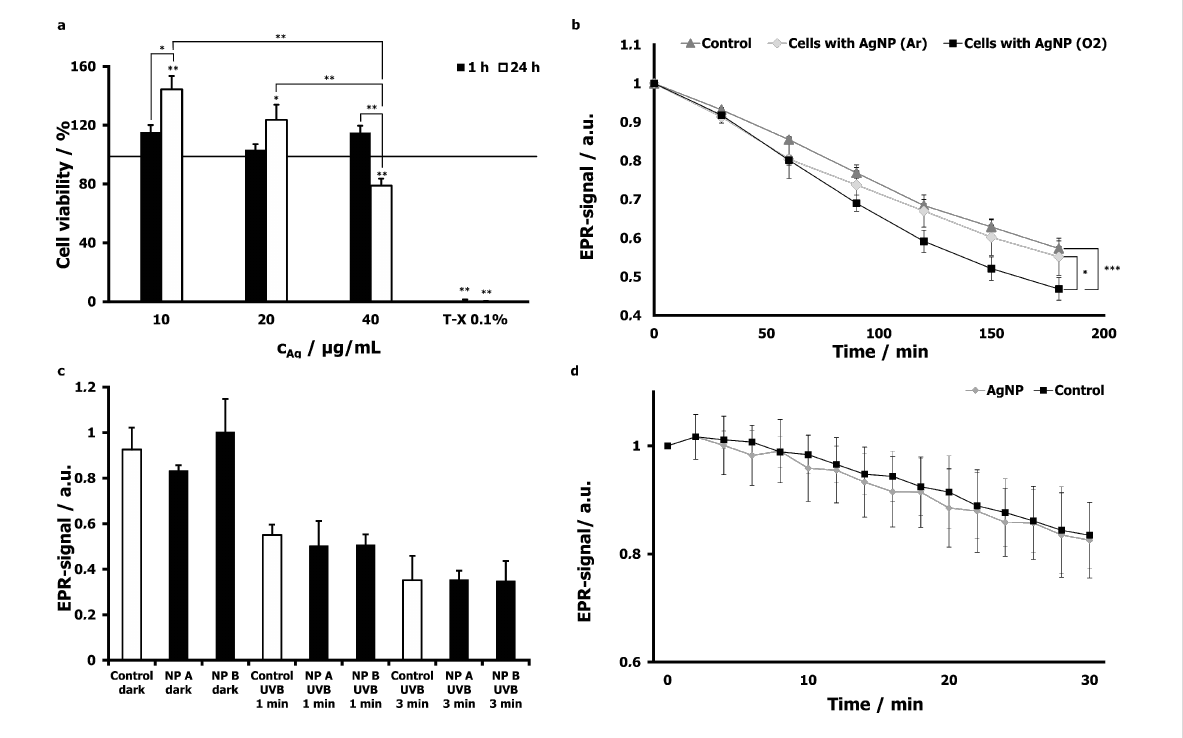
Figure 4: Biological responses of skin tissue and skin cells to particle exposure. The viability of HaCaT cells after 1 h and 24 h incubation with AgNP at different concentrations was assessed by using the XTT assay (a). HaCaT cells were incubated with 30 µg/mL of AgNP produced and stored under ambient air conditions or in argon atmosphere, respectively, and investigated by means of EPR spectroscopy. The used spin marker TEMPO (5 µM) becomes EPR-invisible when reacting with ROS (b). In order to analyze ROS production in whole skin, the EPR-signal intensity was monitored after the application of TiO 2 on porcine ear samples at two different concentrations: 40 mg/mL (NPs A), 400 mg/mL (NPs B) and after irradiation after 1 or 3 min UVB light (210 and 630 mJ/cm 2 , respectively) and respective controls (c). Similarly, the EPR signal of porcine skin was followed after the topical application of AgNP (0.446 mg/mL) for 1 h. Control samples were treated with PBS only